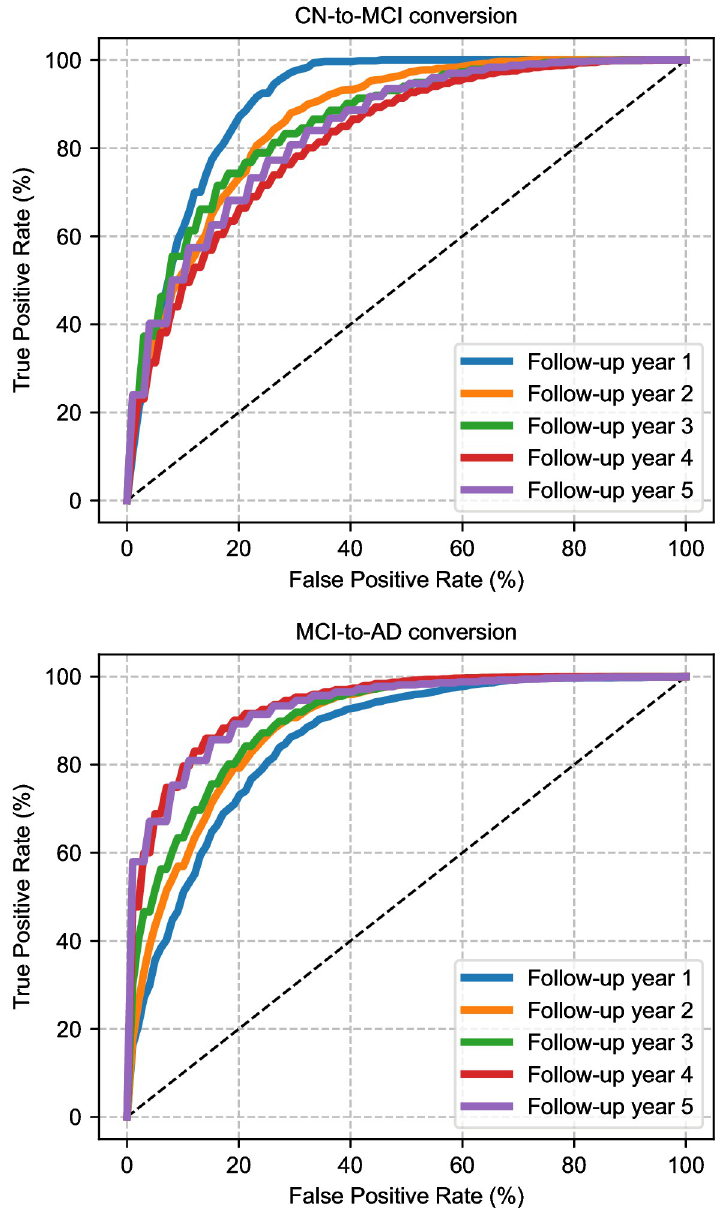
Fig 2. ROC curves of NMM for CN-to-MCI and MCI-to-AD conversion in five-year time horizon. Displayed are averages of 200 train-test splits.